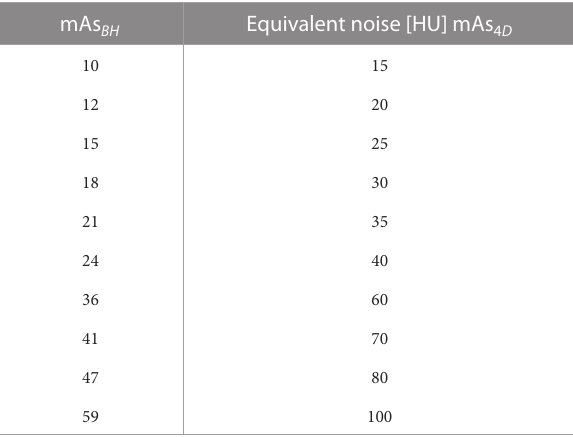
TABLE1 TenmAs BH usedinthisworkarelisted.mAs BH wereselectedusing Eq.